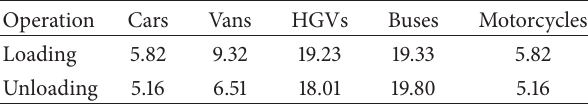
Table 3: Average time (seconds) of loading/unloading operations adopted for the vehicles of each